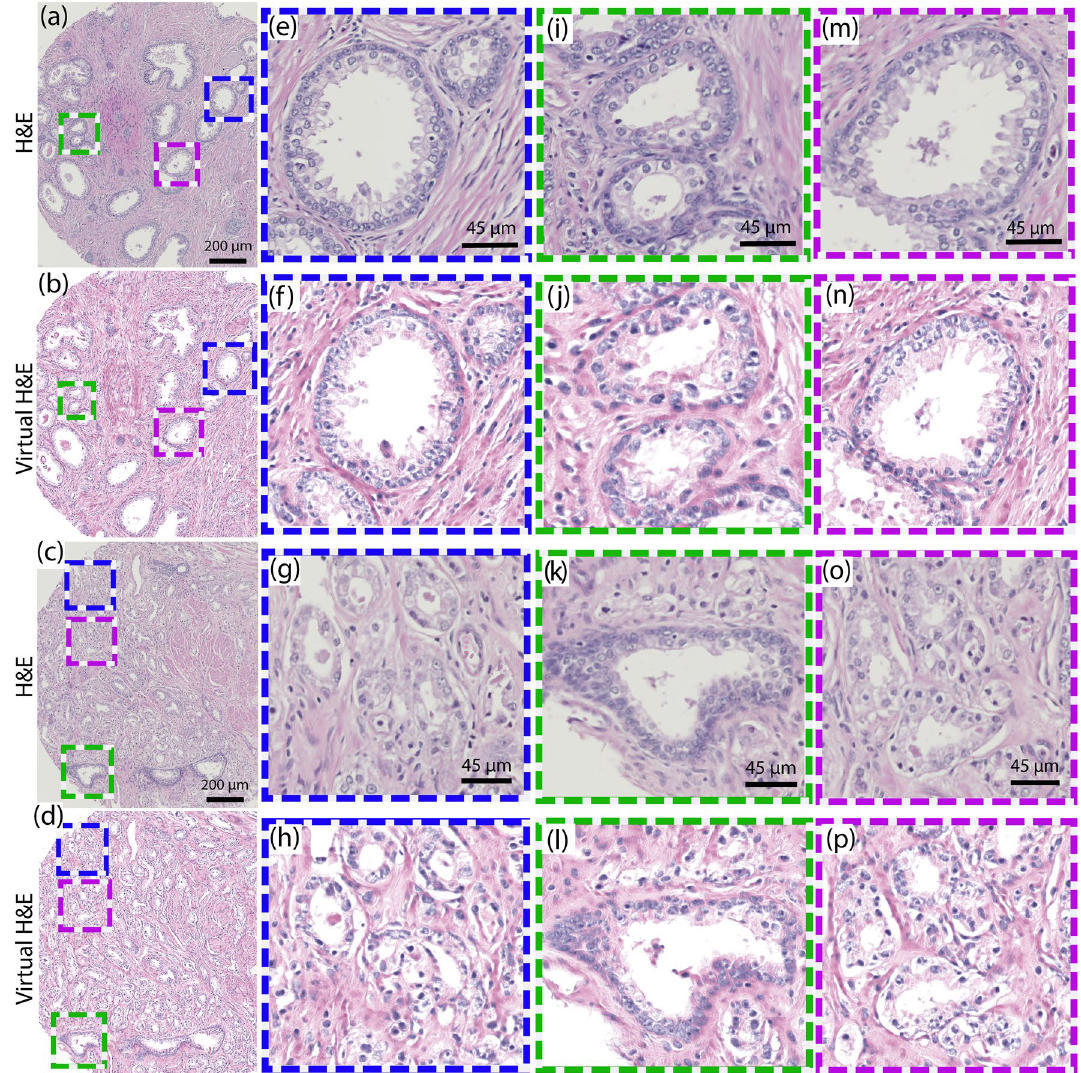
Figure 7. Comparison of translated virtual H&E images and corresponding H&E stained scans. Examples of ( b )–( d ) Two predicted output virtual images ( a ) and ( c ) along with their reference H&E images. ( e ) – ( p ) show three selected zoomed regions for each area. These regions have been selected to compare features on both H&E and translated virtual H&E regions (adjacent slices), all from the UTOM test set. Two pathologists (group 1) were assigned a set of 21 images comprising a mixture of virtual and stained H&E images, and the other two pathologists (group 2) were assigned the complimentary set, meaning images from the same regions but switching virtual H&E images with the images of stained H&E sections, and vice versa (no pathologist viewed the same region in both the virtual H&E and H&E-stained formats). While reviewing the images, pathologists were asked a series of questions regarding the quality of the images, with numerical scores ranging from 1 (poor) to 3 (excellent). They were also asked to provide a Gleason score for each region. Results of the panel study are summarized in Table 1. Data show that the UV translated virtual H&E images and the H&E-stained tissue section images have very similar quality as assessed by the pathologist panel. With the exception of the nucleolus quality, which was evaluated slightly lower in the virtual H&E format, all other structures were assessed to have the same quality between the two modalities, with no statistically significant differences. The gland quality, which is of particular importance for PCa diagnosis, was deemed nearly identical between the two methods, as was the cytoplasm quality. Most importantly, the pathologists’ diagnostic confidence was very similar for both methods (and not statistically different). We attribute the small difference in nucleus quality to the presence of lipid-laden macrophages (Xanthoma), mesonephric remnants, and hyperchromatic nuclei in a few regions with inflammation, which have a slightly disrupted visible quality in the translated images. However, (1) these are not diagnostically meaningful (which is likely why the diagnostic confidence remained the same between the two groups, even though the nucleus quality was slightly lower in the UV translated images), and (2) the nucleus quality can be improved with additional training.